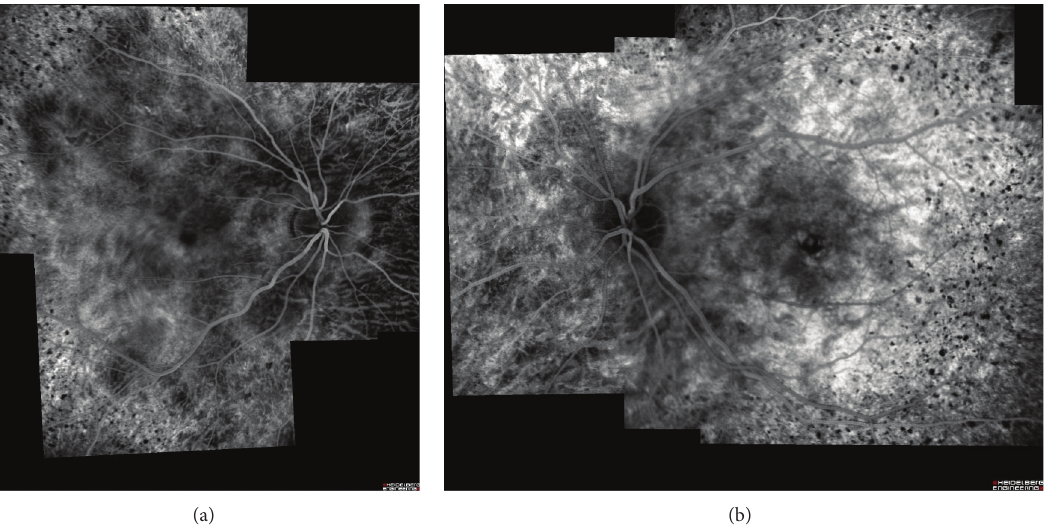
Figure3:Fluoresceinangiogram,compositepicture,latevenousphaseshowingcystoidmacularedema,blockingeffectofintraretinalcrystals, and slight chorioretinal atrophy. (a) Right eye (b) and left